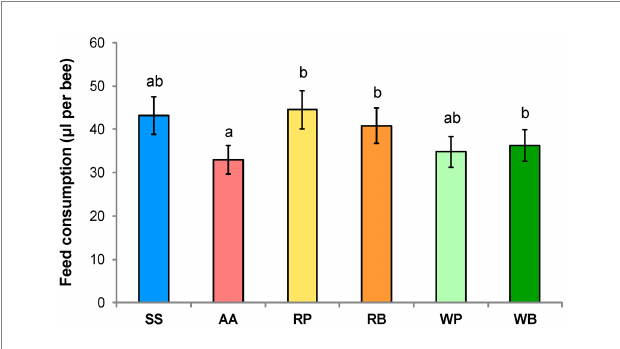
FIGURE 1 Consumption of different diets ( μ l per one bee). SS, sucrose solution (control group); AA, sucrose solution + amino acids; RP, sucrose solution + rapeseed pollen; RB, sucrose solution + rapeseed beebread; WP, sucrose solution + willow pollen; and WB, sucrose solution + willow beebread. Different letters indicate significant differences between the values ( p < 0.05).